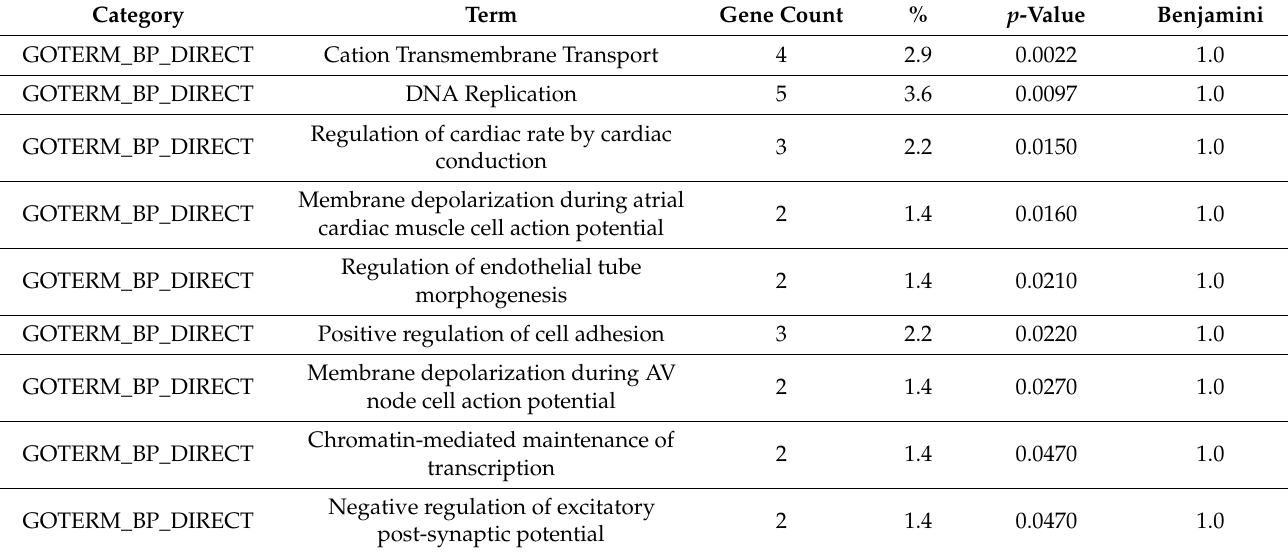
Table 2. Gene ontology (GO)-based biological process enrichment analysis ( p -value ≤ 0.05).